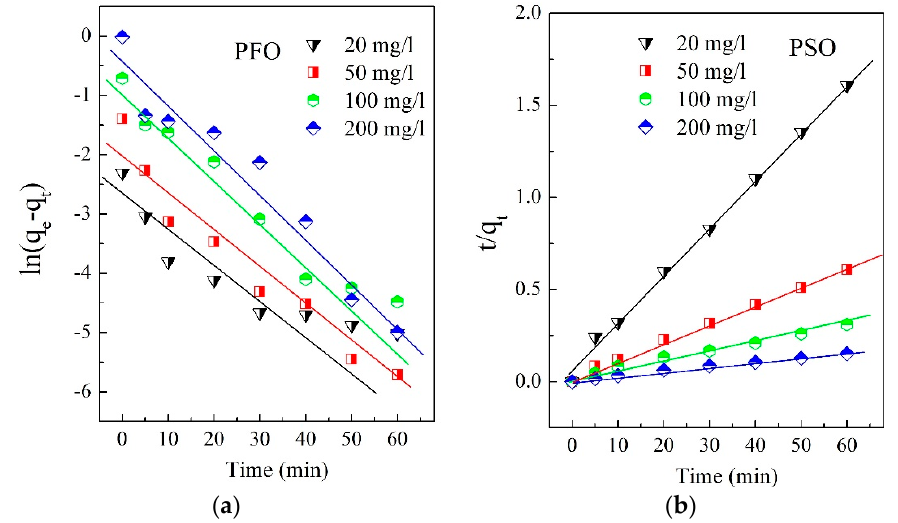
Figure 8. Kinetic modeling of MO adsorption using pseudo-first-order (PFO) ( a ) and pseudo-secondo-rder (PSO) model ( b ). Table 2. Kinetic parameters for MO